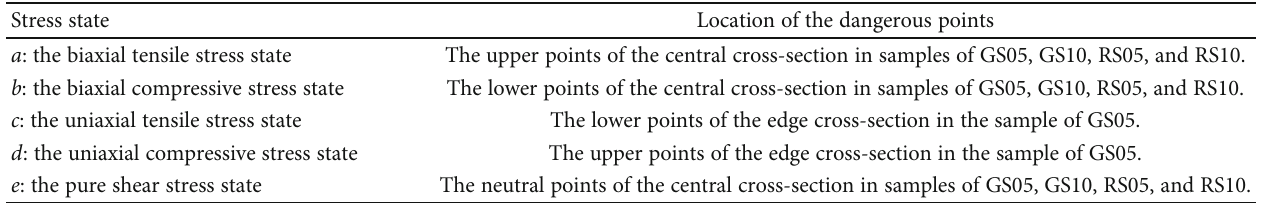
Table 5: The details of the stress state at the dangerous points. Stress state Location of the dangerous points The lower points of the central cross-section in samples of GS05, GS10, RS05, and RS10. The lower points of the edge cross-section in the sample of GS05. The upper points of the edge cross-section in the sample of GS05.